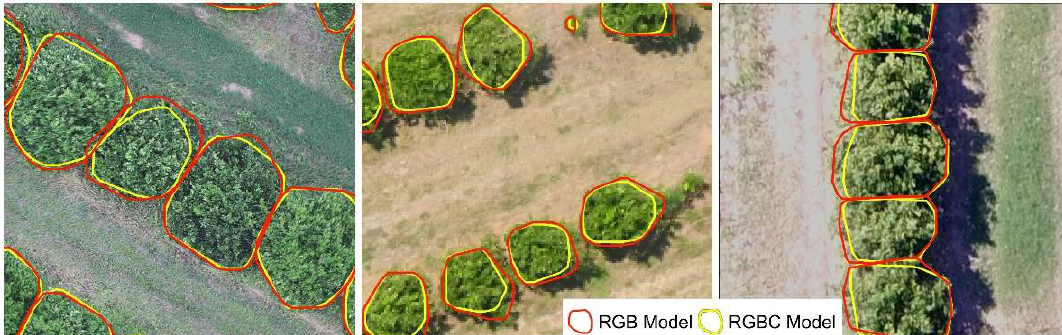
Figure 10. Examples of the difference in canopy delineation between models.